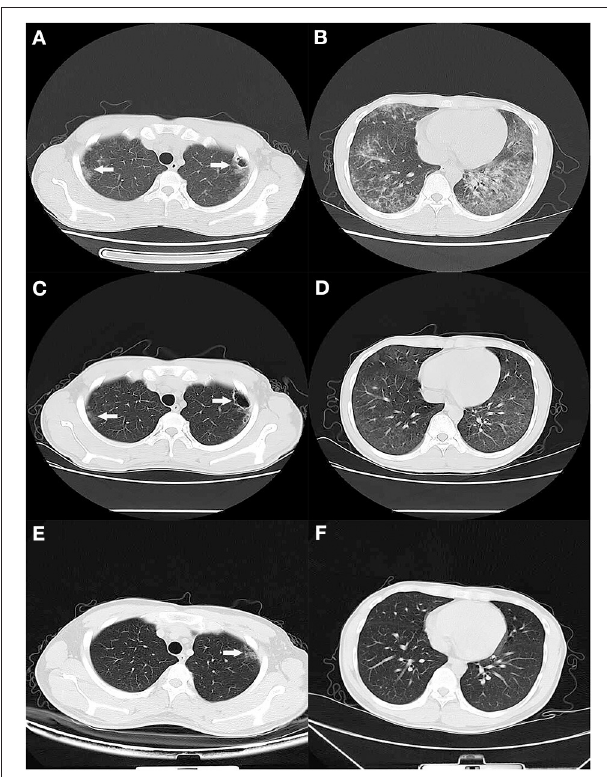
FIGURE 1 | CT scan of the lung. (A,B) On the 1st day of admission, a CT scan showed diffuse bilateral ground-glass opacities with thin-walled cavity lesions (white arrow) in the left upper lung. (C,D) After 2 weeks of treatment, a CT scan showed that lesions were significantly absorbed except for a faint patchy opacity in the lateral segment and thin-walled cavity lesions (white arrow) in the left upper lung. (E,F) Two months later, a CT scan exhibited no abnormal finding except for a faint patchy opacity (white arrow) in the left upper lateral segment.